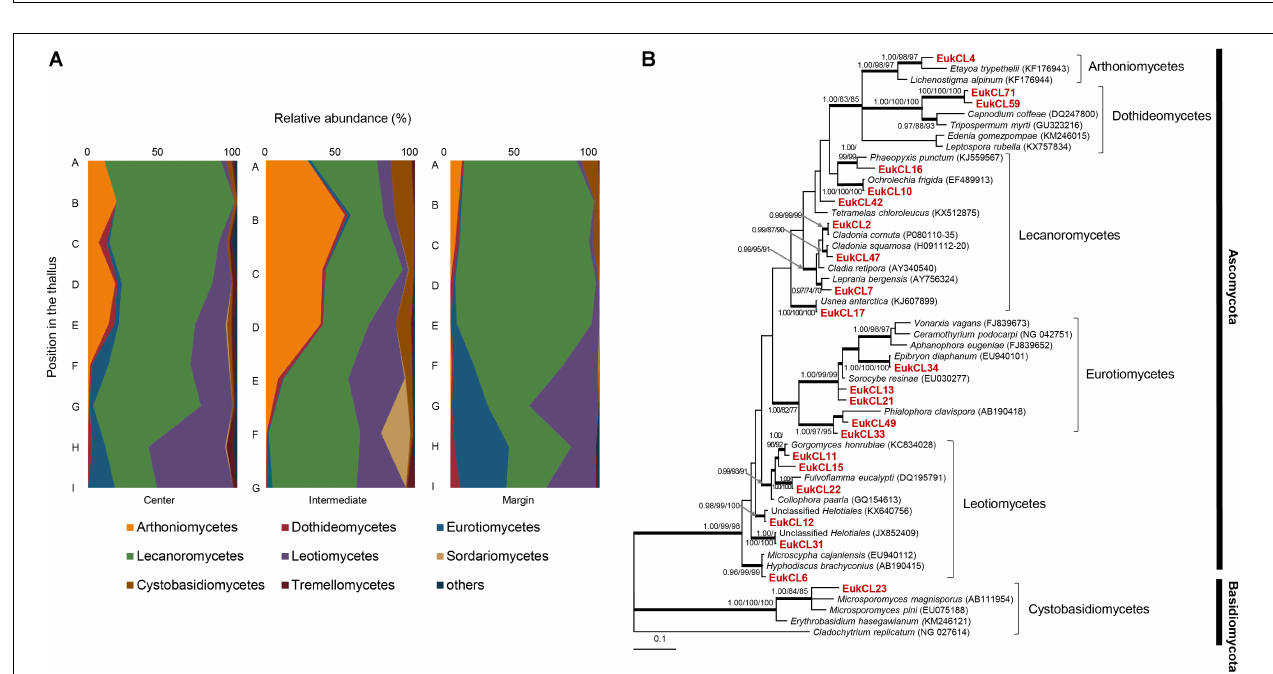
FIGURE 3 | Algal composition along the thalli and phylogenetic tree of the major algal OTUs. (A) Relative abundance of 10 major algal OTUs ( > 0.5% relative abundance). Positions of thalli in the colony and labels of subsection were illustrated in Figure 1B . (B) Bayesian tree of 10 major algal OTUs with closely related reference sequences. Thick branches represent those that were conserved in Bayesian, ML, and MP analyses. Posterior probabilities and bootstrap values ( > 0.9 and > 70%) were shown on corresponding branches (Bayesian/ML/MP). The tree was rooted with Scherffelia dubia (HE610128, Chlorodendrophyceae). Detailed information for relative abundance of each OTU was included in Supplementary Table S2 .